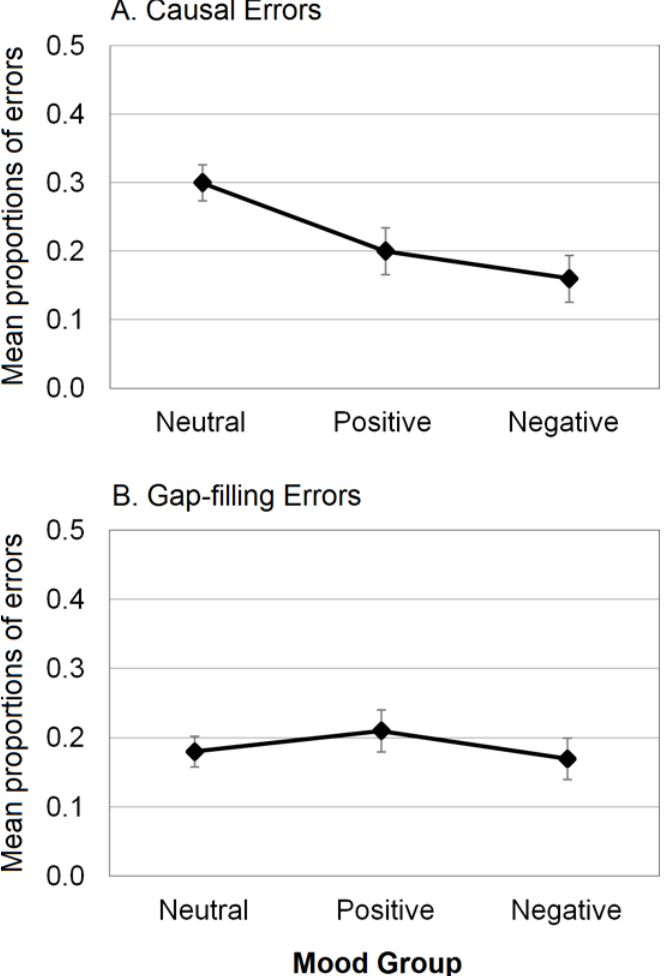
Fig 1. Mean proportions of causal errors (A) and gap-filling errors (B) as a function of mood group ; error bars represent standard errors.